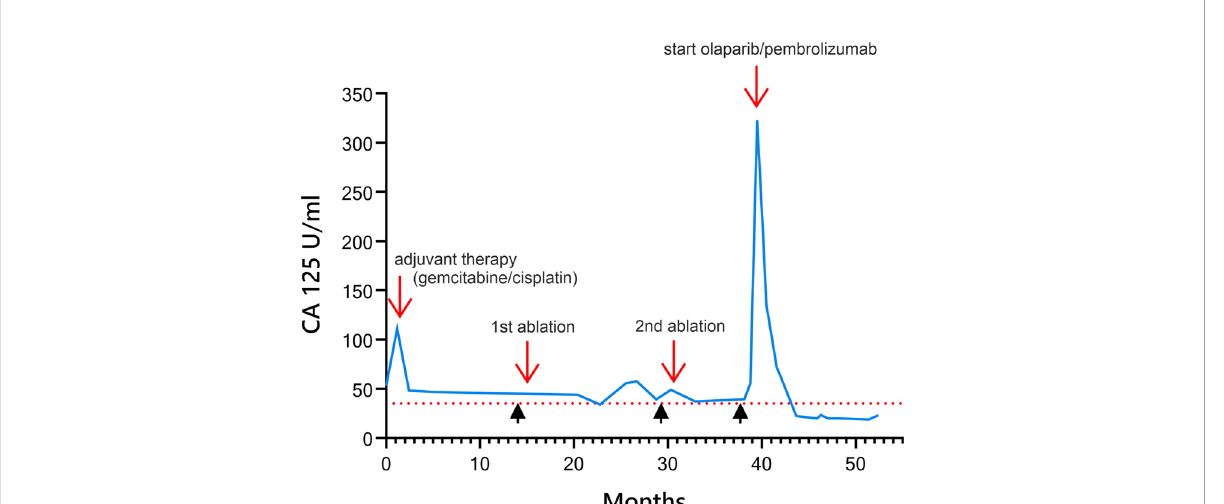
FIGURE 2 Diagram of development of Ca 125 in U/ml over time after primary hemihepatectomy during the disease course and under multimodal therapy. Red arrows are labeled with therapeutic events. Black arrow heads indicate time of recurrence as diagnosed by imaging.